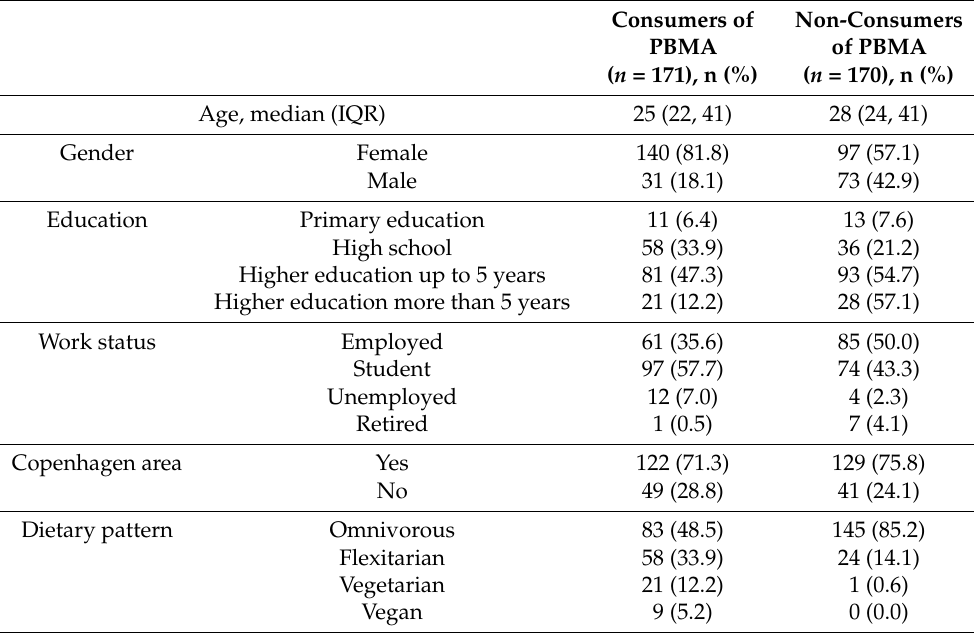
Table 2. Socio-demographic characteristics of participants stratified by consumers and non-consumers of PBMA.